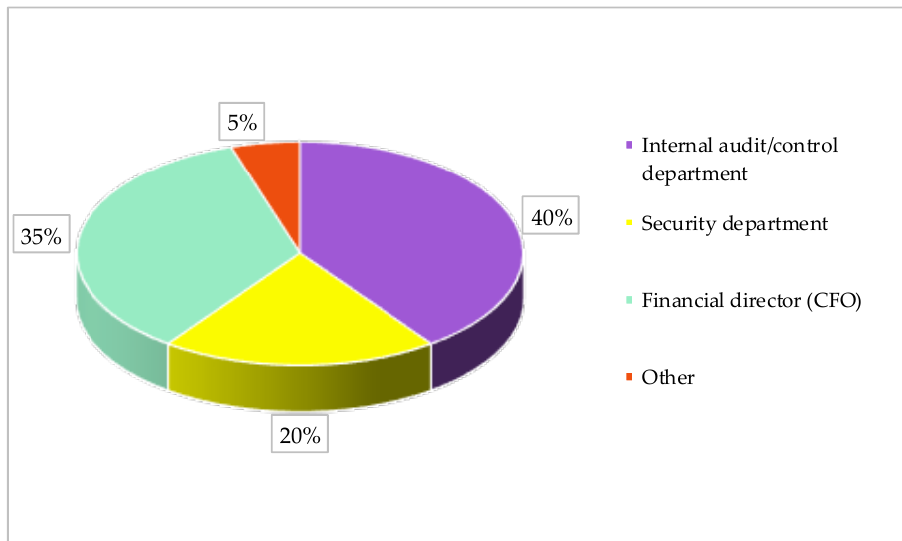
Figure 2. Responsibility for the coordination of risk management processes in the absence of a separate structural division in 50 Polish companies. Source: authors’ study.